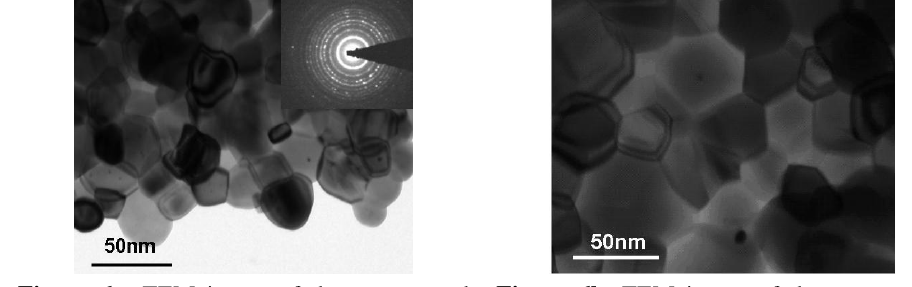
Figure 6b. TEM image of the